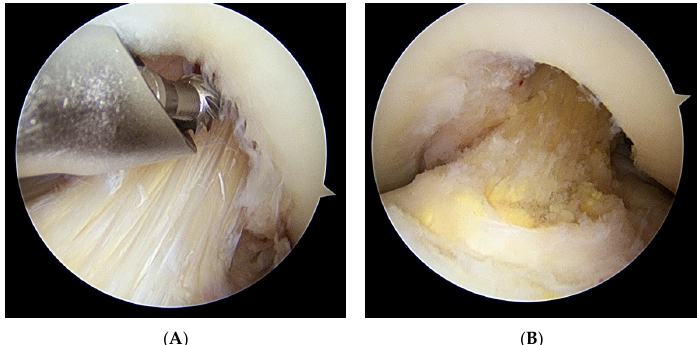
Figure 3. ( A ). Arthroscopic findings through the anterolateral portal of the left knee show a narrow intercondylar notch and hypertrophied anterior cruciate ligament (ACL. Notchplasty was performed first by using a motorized burr. ( B ). The hypertrophied ACL was then resected to <50% of the volume to achieve impingement-free motion between the ACL and intercondylar notch.